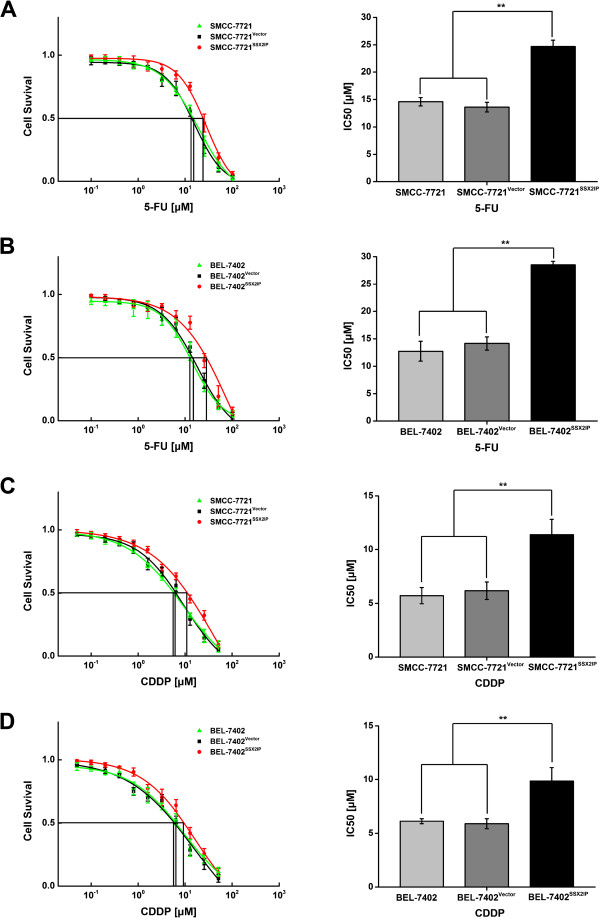
SSX2IP reduces the sensitivity of hepatocellular carcinoma cells to chemotherapeutic drugs. A. Dose–response curves and IC50 values for 5-Fu between SMMC-7721, SMMC-7721Vector and SMMC-7721SSX2IP cell lines. B. Dose–response curves and IC50 values for 5-Fu between BEL-7402, BEL-7402Vector and BEL-7402SSX2IP cell lines. C. Dose–response curves and IC50 values for CDDP between SMMC-7721, SMMC-7721Vector and SMMC-7721SSX2IP cell lines. D. Dose–response curves and IC50 values for CDDP between BEL-7402, BEL-7402Vector and BEL-7402SSX2IP cell lines. The IC50 values of SMMC-7721SSX2IP and BEL-7402SSX2IP cell lines for 5-Fu and CDDP are higher, compared to those in control groups (**P < 0.001).